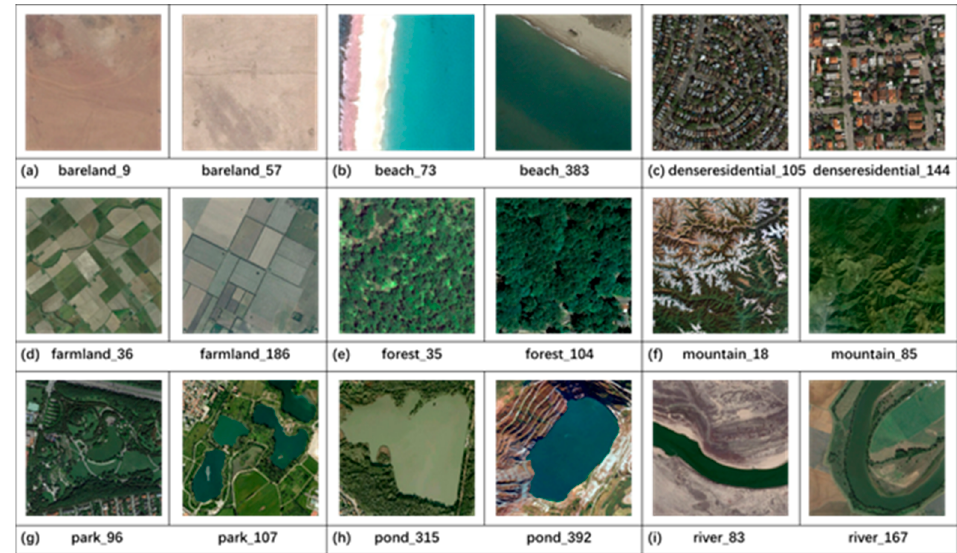
Figure 6. Random samples from the AID scene dataset.